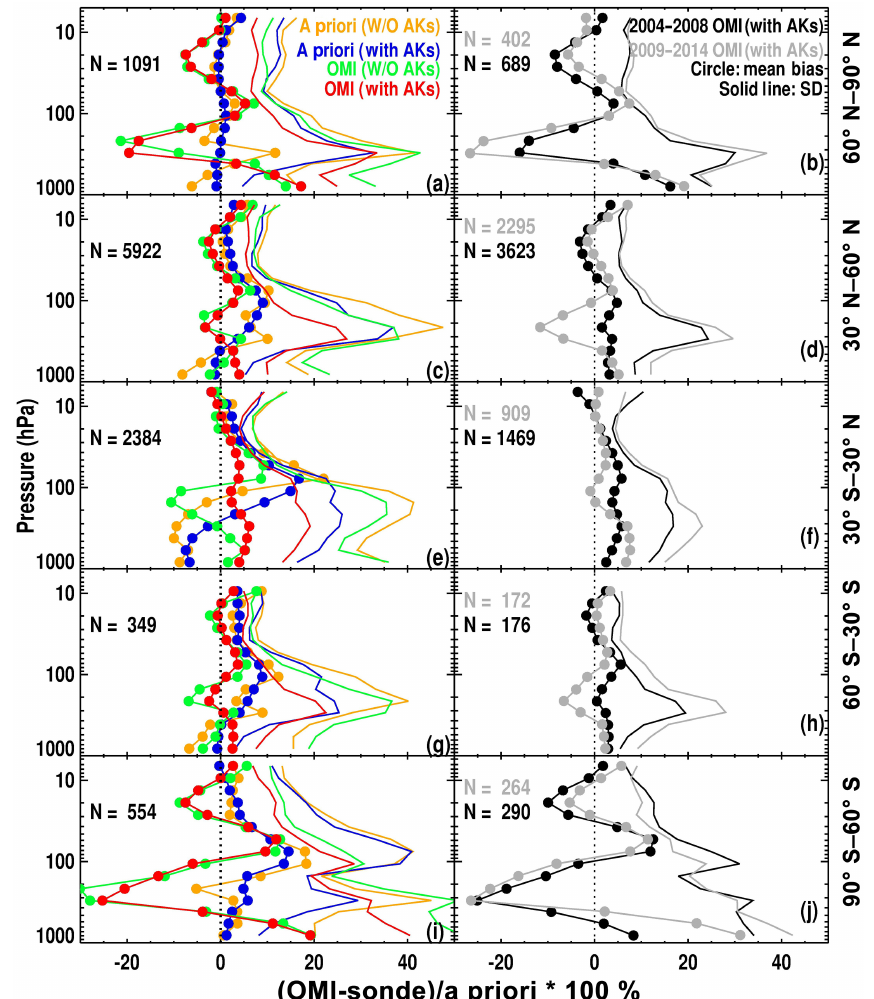
Figure 3. Mean relative biases in ozone (line with circles) and corresponding standard deviations (solid lines) between OMI retrieval–a priori and ozonesondes with and without (W/O) applying OMI retrieval averaging kernels (i.e., with AKs and without AKs in red and green for comparing retrievals and in blue and yellow for comparing a priori) for five different latitude bands. The left panels show the comparison using 10 years of OMI data (2004–2014), and the right panels show the comparison between OMI retrieval and ozonesonde with OMI AKs for before and after the occurrence of serious OMI row anomaly (RA), i.e., pre-RA (2004–2008) in black and post-RA (2009–2014) in gray. The number ( N ) of OMI–ozonesonde coincidences used in the comparison is indicated in the